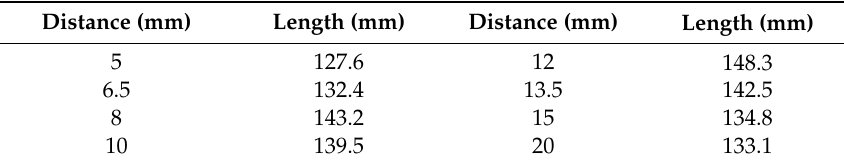
Table 3. Simulation results under di ff erent installation